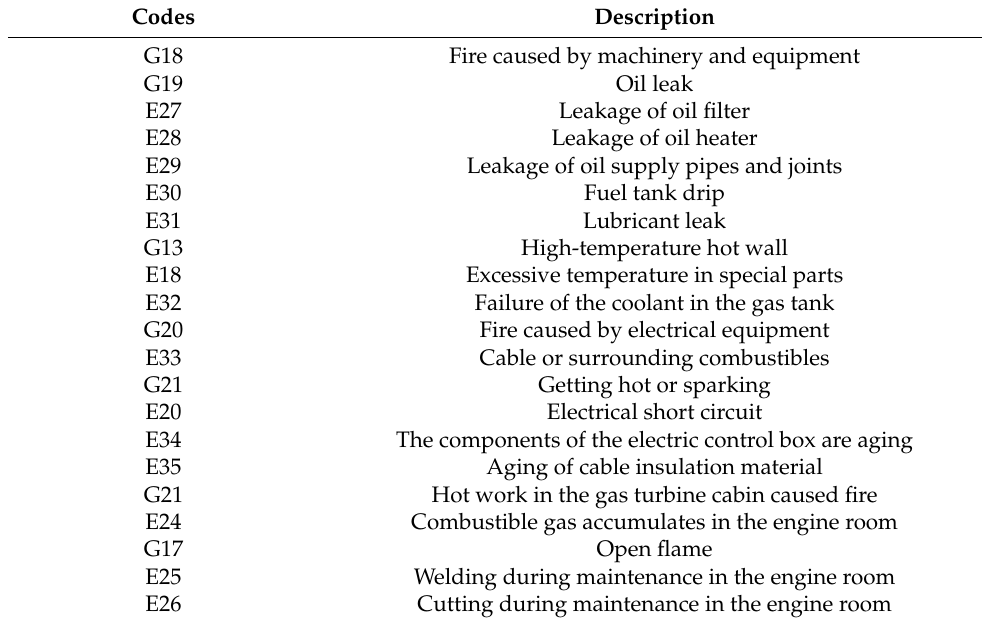
Table 9. Logic gates and principal events of a gas turbine room fire.